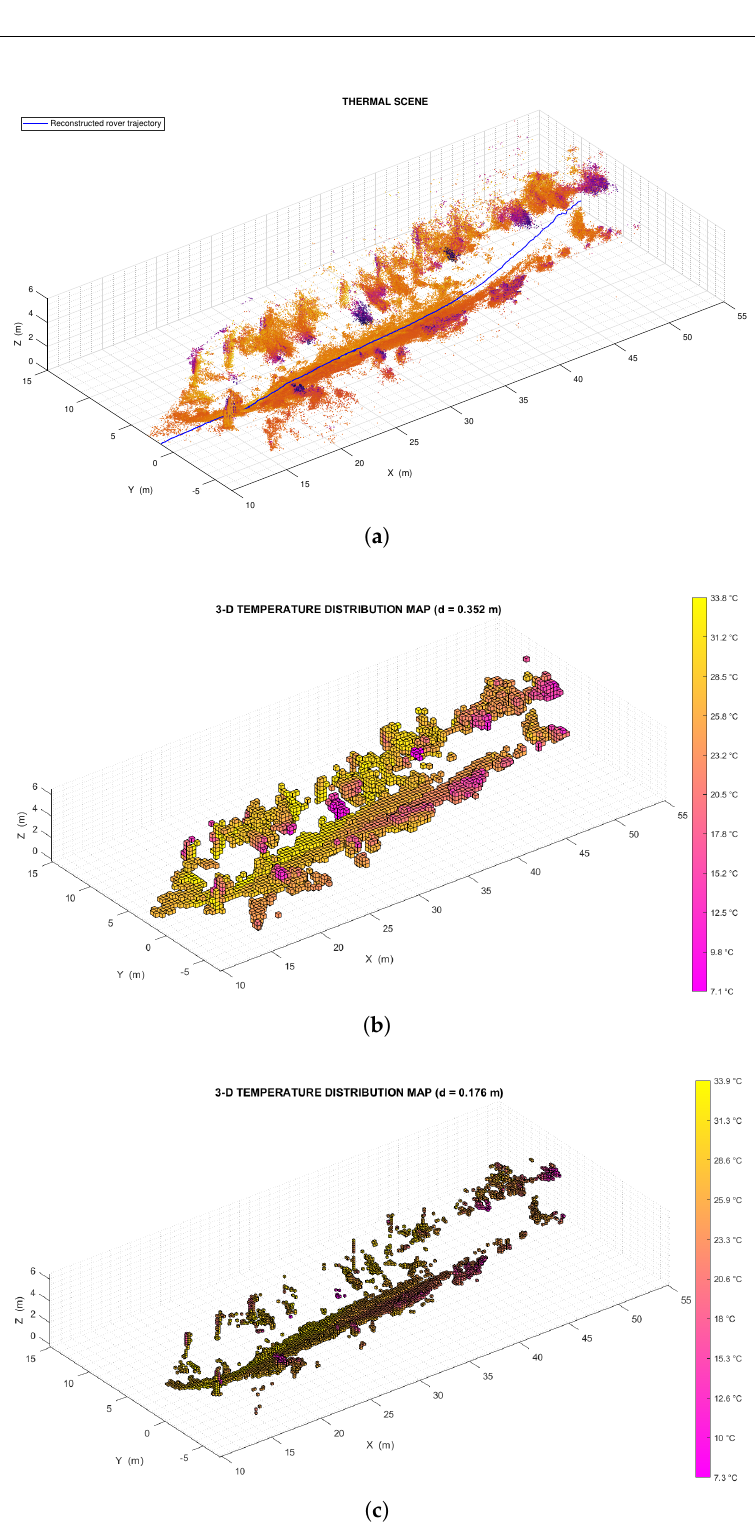
Figure 14. ( a ) Portion of the thermal scene produced during the test in the outdoor environment. Here the blue line represents the estimated trajectory of the rover, which was reconstructed using the livox_horizon_loam algorithm. ( b ) Low resolution (voxel size equal to 0.35 m) temperature distribution map relative to the outdoor test environment. ( c ) High resolution (voxel size equal to 0.18 m) temperature distribution map relative to the outdoor test environment. Again, the high resolution map was obtained from the same OcTree data structure as the low resolution temperature distribution map (with the difference being that the first map corresponds to the eighth level of the structure, and the second to the ninth